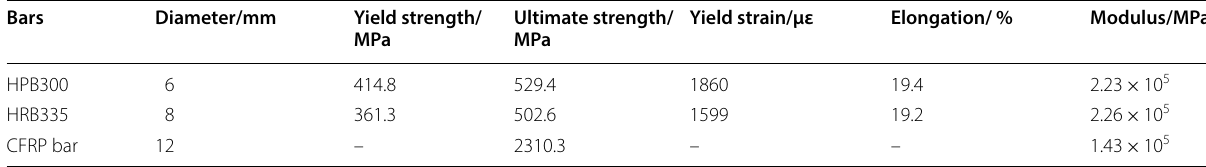
Table 1 Properties of bars.